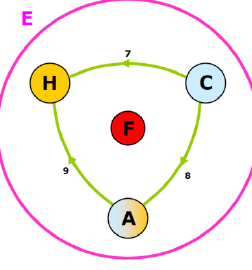
Fig. 5. – Heat recovery, free cooling and free